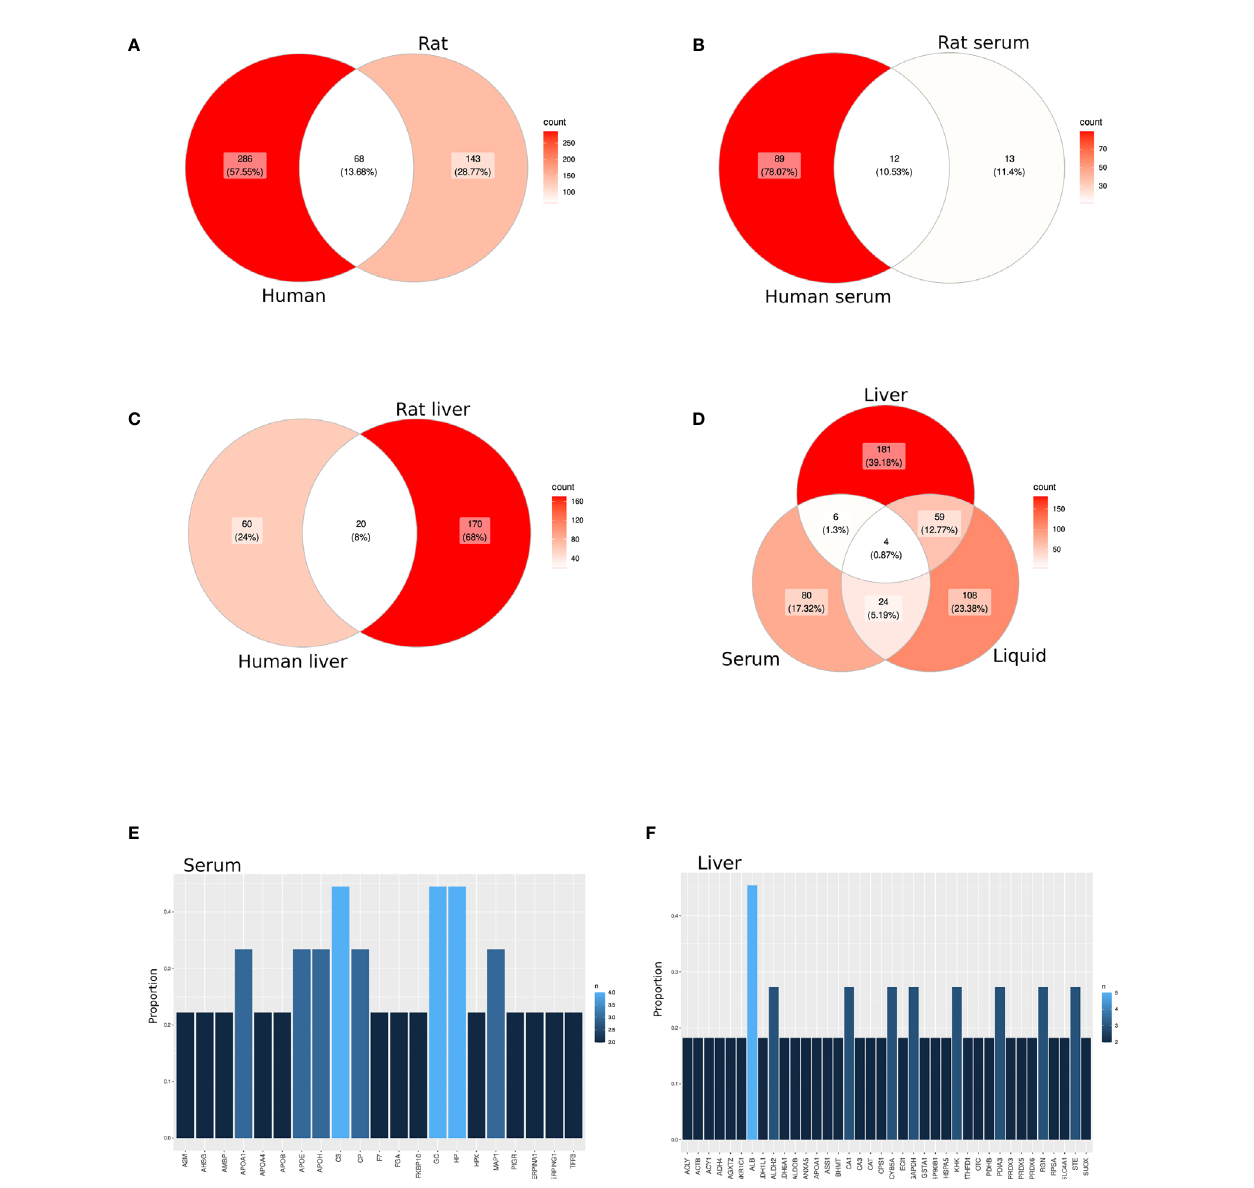
FIGURE 2 | Candidate protein biomarkers from different sample source. (A – D) Venn diagram among all selected studies in a cross-species (A – C) or cross-sample source (D) analysis. (E, F) Bar graph representing the most shared proteins among all selected studies in serum/plasma (E) or liver biopsies (F)